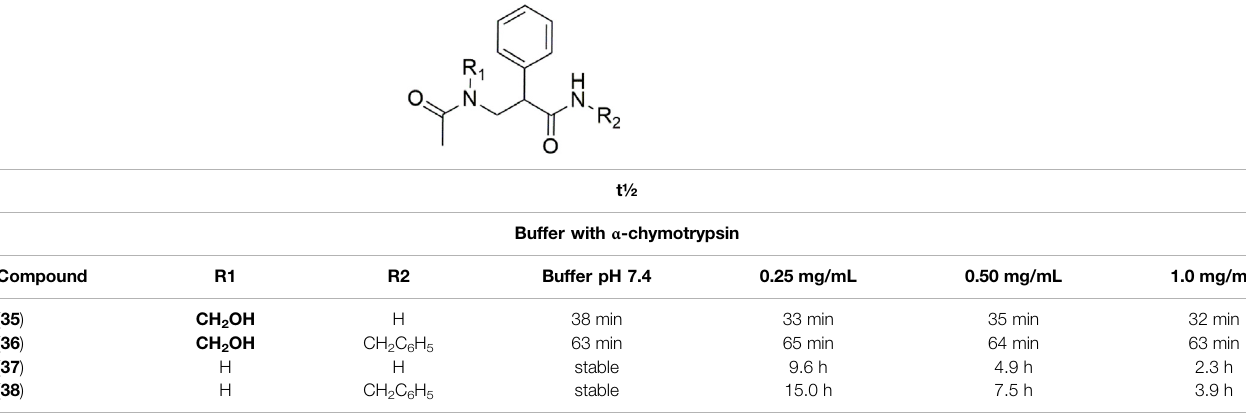
TABLE 3 | Half-life (t½) in pH 7.4 and in buffer containing α -chymotrypsin (Kahns, Friis, Bundgaard, 1993).